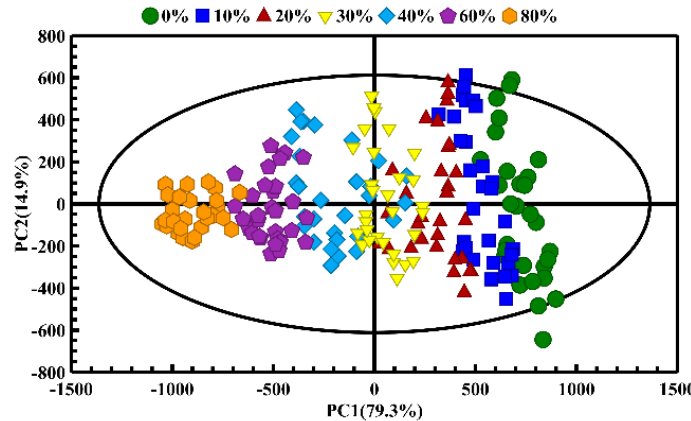
Figure 5. The PCA score plots of the camellia oil (CA) adulterated with different adulteration ratios of corn oil (CO).